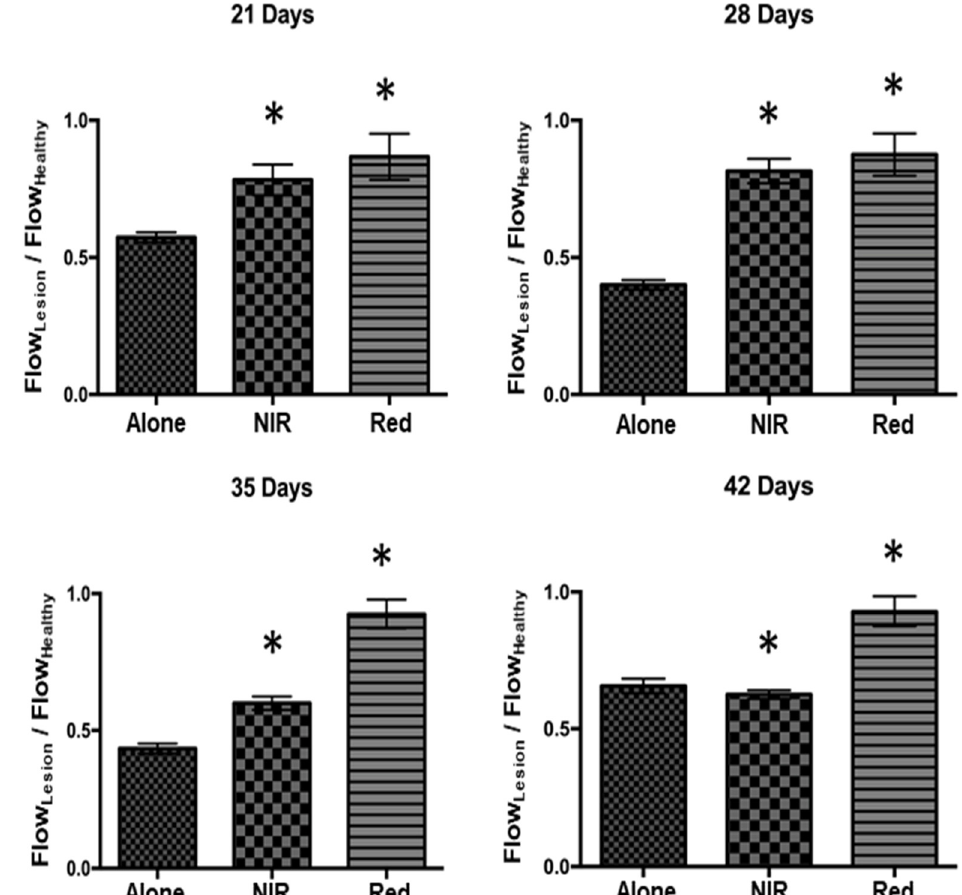
Figure 3. Vascular perfusion in radionecrosis lesion, compared with adjacent healthy skin in radiation and PBM-treated groups at 21, 28, 35, and 42 days. Data are presented as means with standard deviation; * denotes statistical significance n = 6, p < 0.05 with Kruskal–Wallis and Dunn’s test.